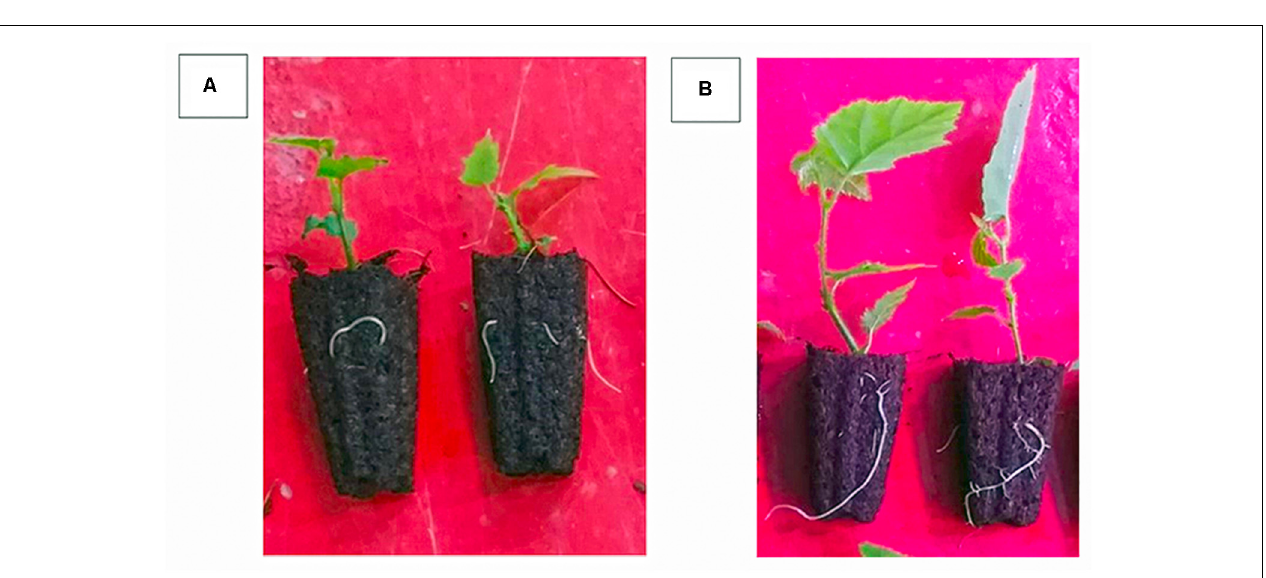
FIGURE 11 | Effect of different auxin treatments on plant growth of Corylus avellana L. cv. “Fertile de Coutard.” (A) IBA-K (3 µ M); (B) diluted IAA-E C1 solution (IAA = 1 µ M).